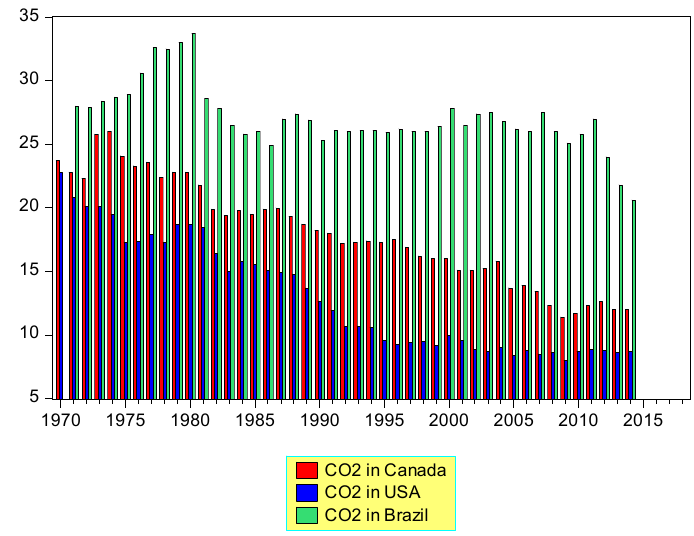
Figure 2. CO 2 evolution in Canada, USA and Brazil.